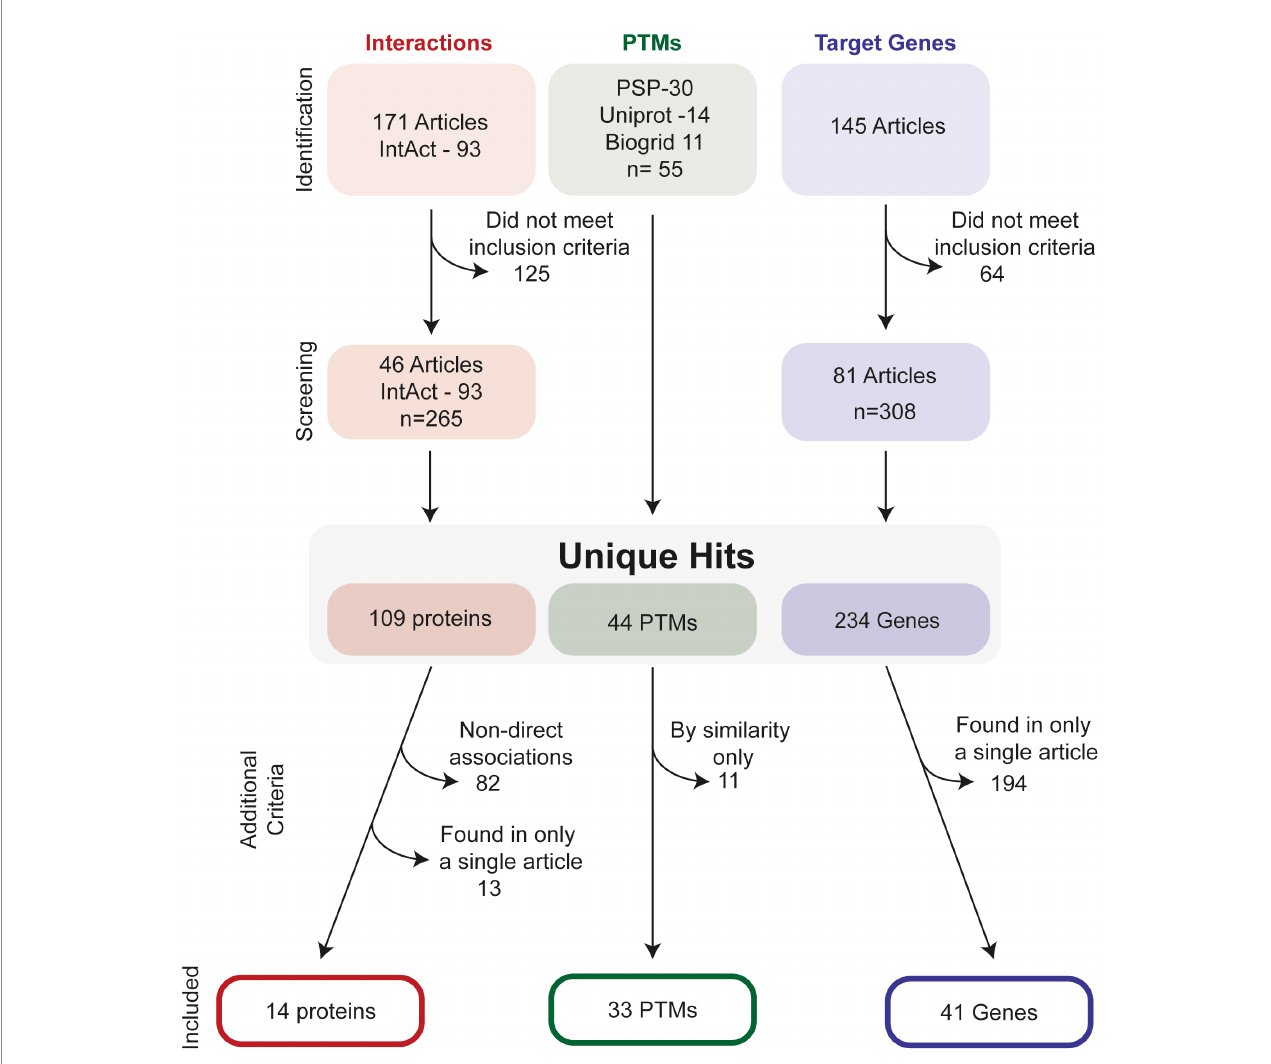
FIGURE 2 Selection process to identify relevant ATF4-interactors, PTMs and target-genes. For interactions studies, a total of 171 studies were investigated in addition to 93 interactions listed on the IntAct database, this was screened to identify an additional 65 unique interaction partners. After removal of interactions with non-direct evidence and those found only in a single publication, 14 proteins were identified. For PTMs, PhosphositePlus (PSP), Uniprot and Biogrid were all screened for PTMs. After checking for duplicates, 44 hits remained. Removal of predicted, i.e., as of yet observed PTMs in human, resulted in 33 PTMS. For target genes, 145 relevant articles were found from literature database searches, and after application of inclusion criteria, a total of 234 possible gene targets were identified. After stringency criteria were applied, a total of 41 hits were